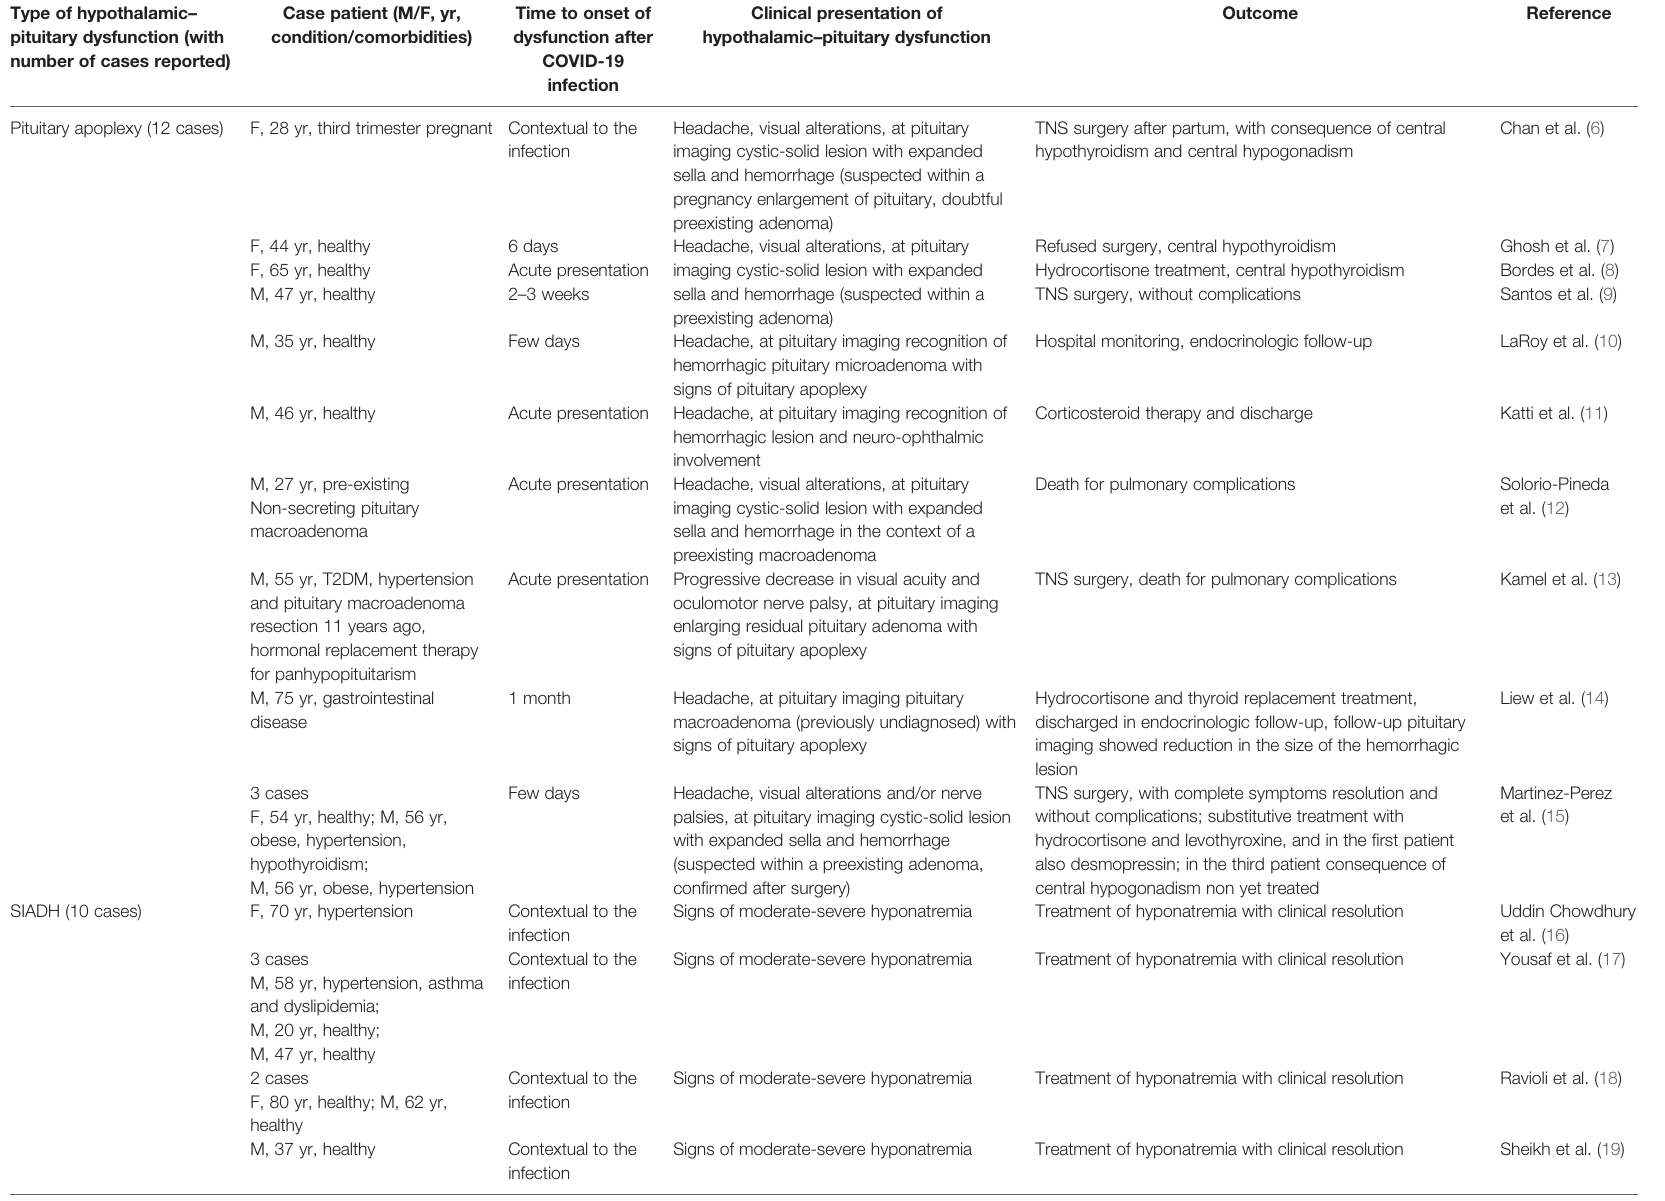
TABLE 1 | Cases in literatures of hypothalamic – pituitary dysfunction after COVID-19 infection in adults. Type of hypothalamic – pituitary dysfunction